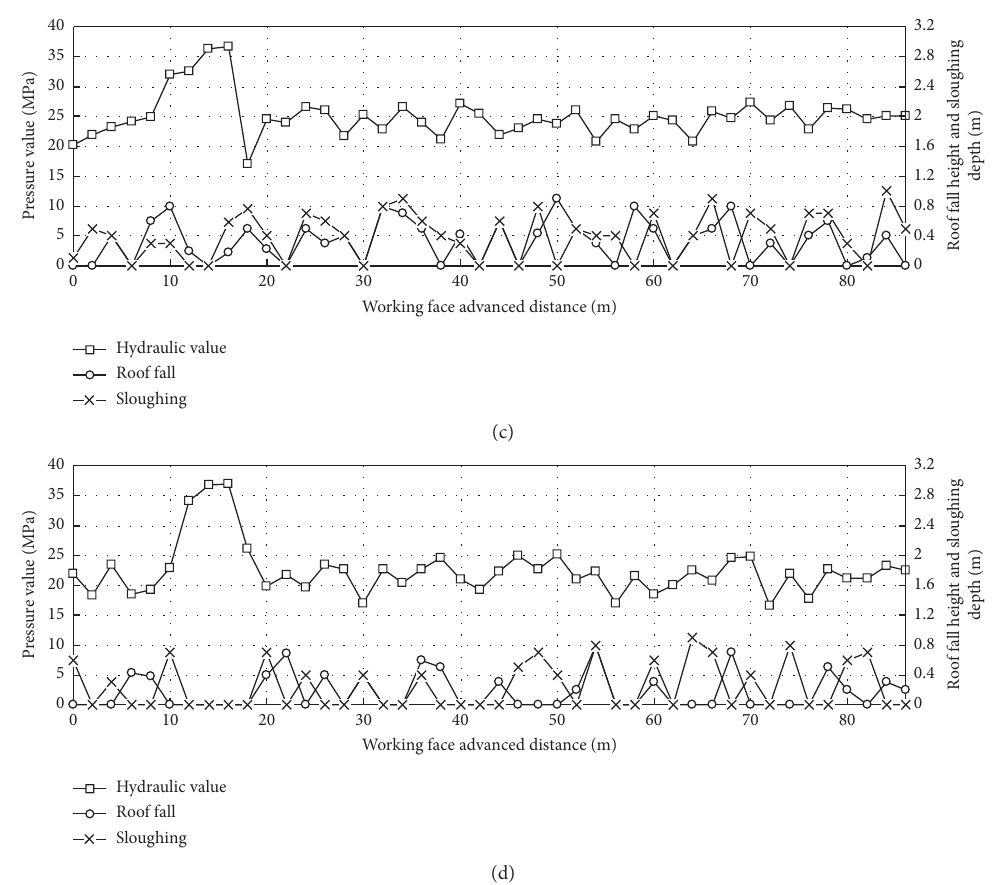
Figure 15: Hydraulic information of support and variation characteristics of roof fall and sloughing. (a) Upper region; (b) middle region; (c) coal pillar region; (d) lower